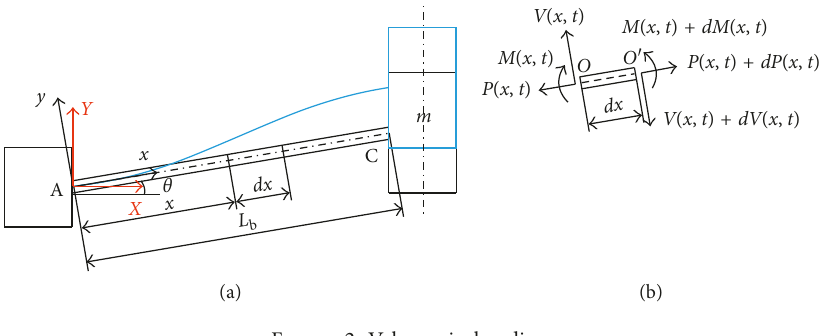
Figure 2: V-beam in bending.